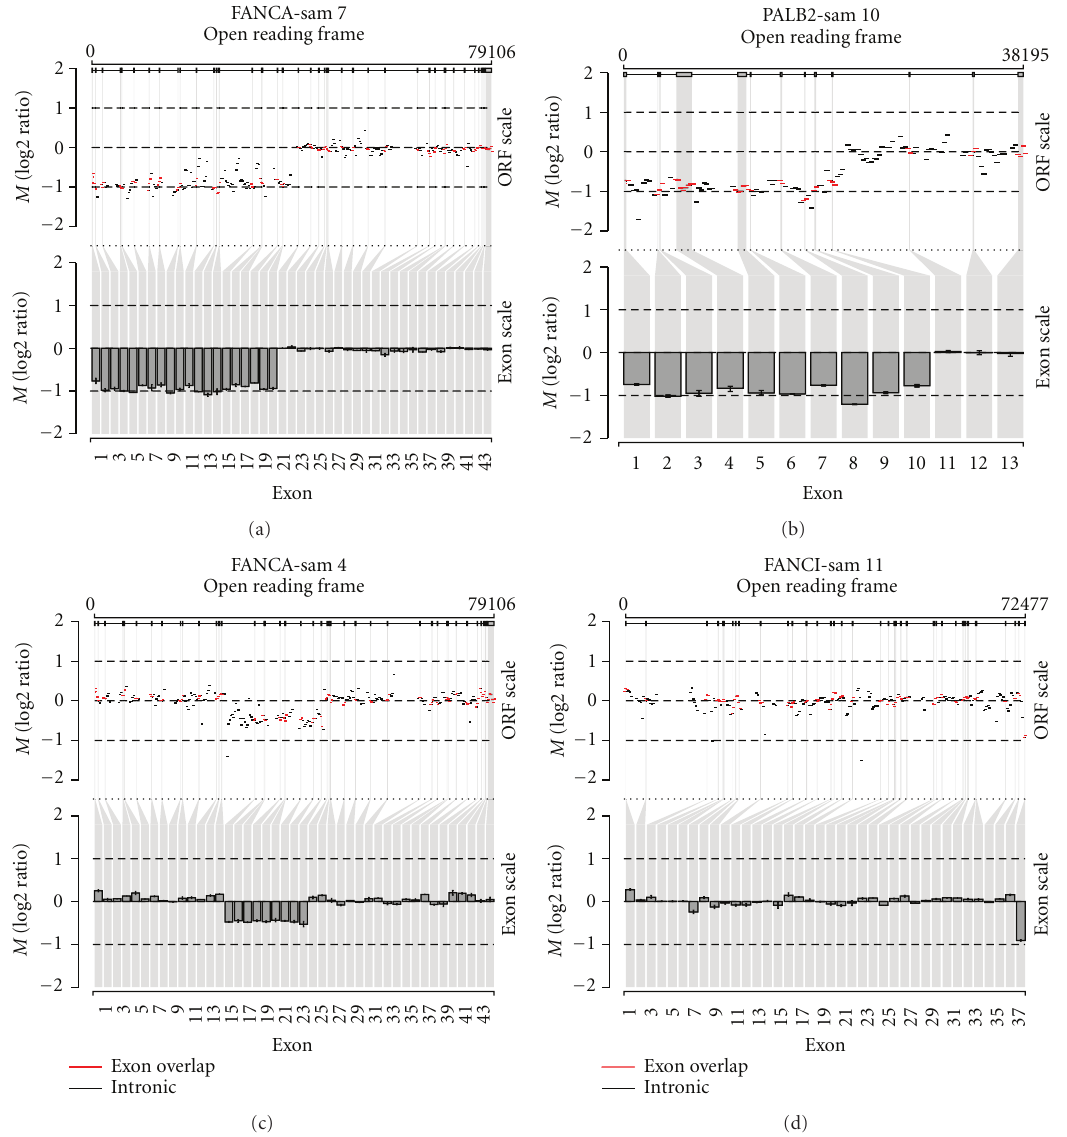
Figure 2: Large detection using next-generation sequence data. Copy number data are projected on an open reading frame (ORF) and on an exon scale. The ORF scale (upper panel) shows log2 ratios ( M ) for all exons and introns. Red segments indicate an overlap with an exon and black segments indicate no overlap with exons. The exon scale (lower panel) only shows the mean log2 ratio per exon with their 25th and 75th percentile. R plots of large deletion analysis. Deletion of exons 1 to 20 of FANCA (a), exons 1 to 10 of FANCN (b), exons 15 to 23 in FANCA (c), and exon 38 in FANCI